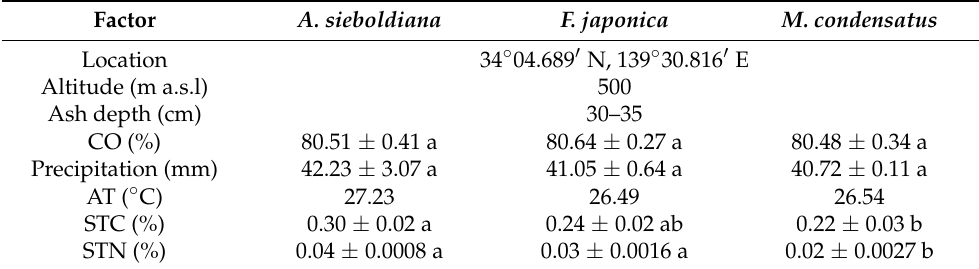
Table 1. Location and growth environment of each pioneer species in study site. Different letters indicate significant differences between the pioneer species revealed by Tukey’s post hoc test at a significance level p < 0.05 after one-way ANOVA. Abbreviations are meters above sea level (m a.s.l); canopy openness (CO) ( n = 15); air temperature (AT); soil total carbon (STC) ( n = 15); total soil N (STN) ( n =